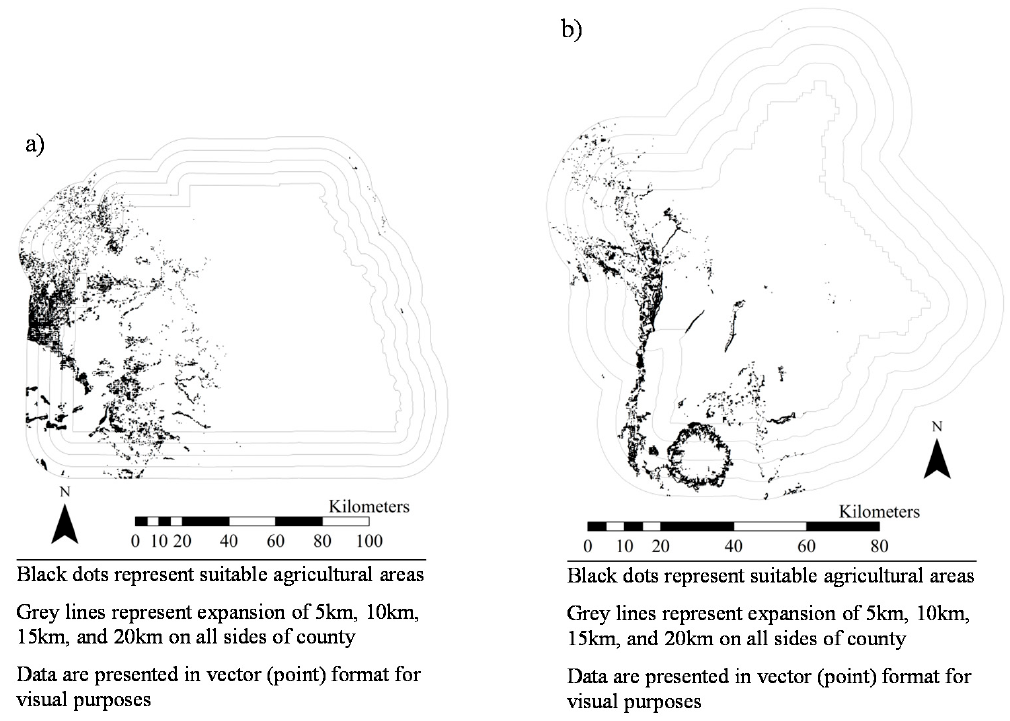
Figure 2. Suitable agricultural land for kiwis in ( a ) Tulare County, California and ( b ) Butte County, California.